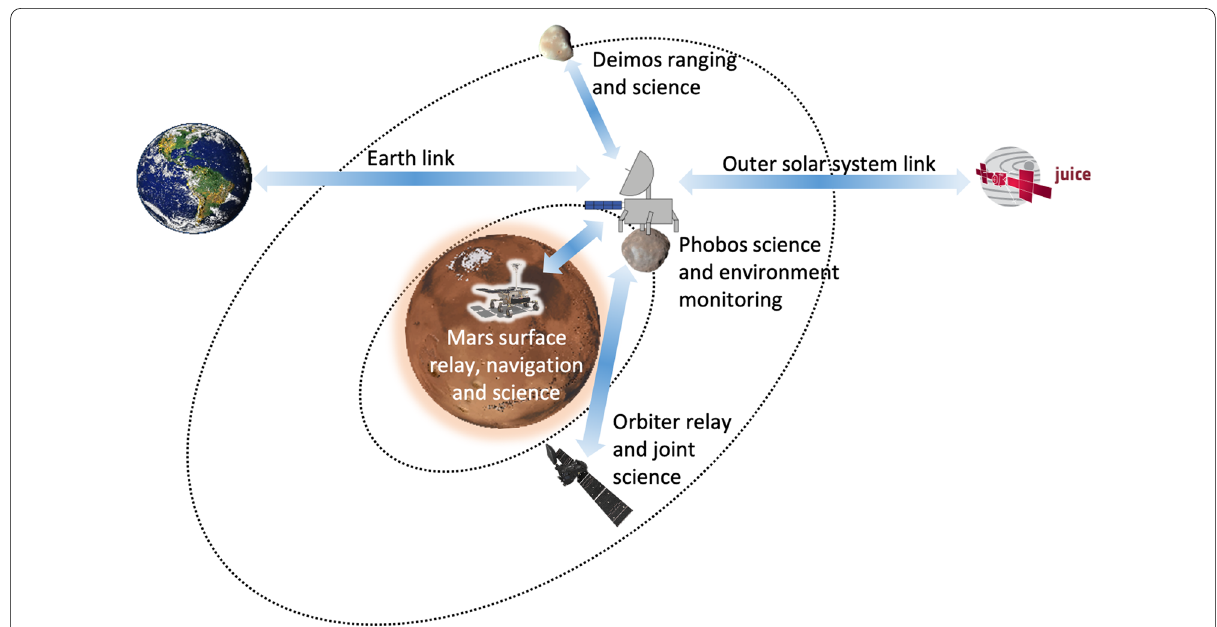
Fig. 1 Functionalities of a long‑term landed platform on